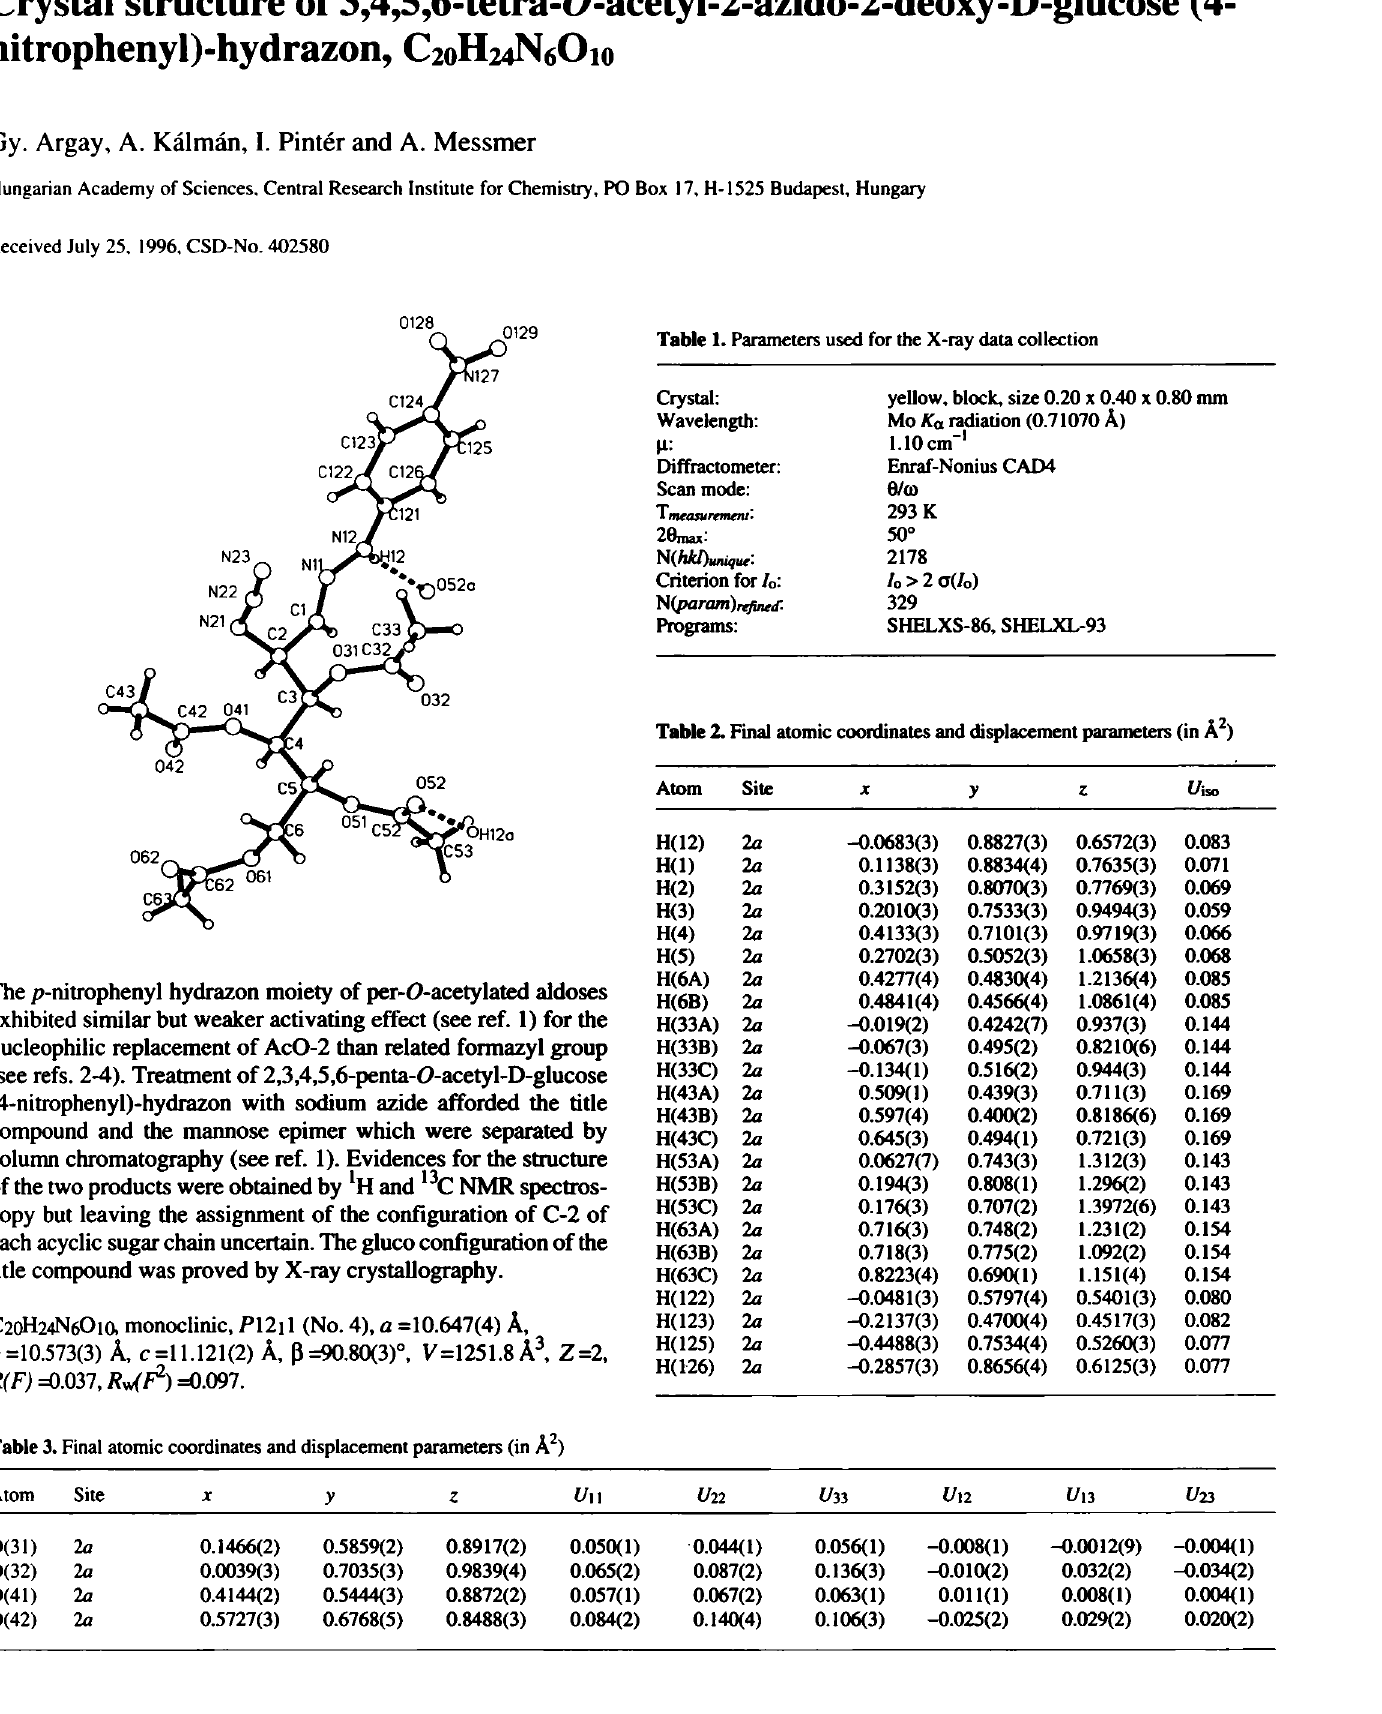
Table 1. Parameters used for the X-ray data collection Crystal: